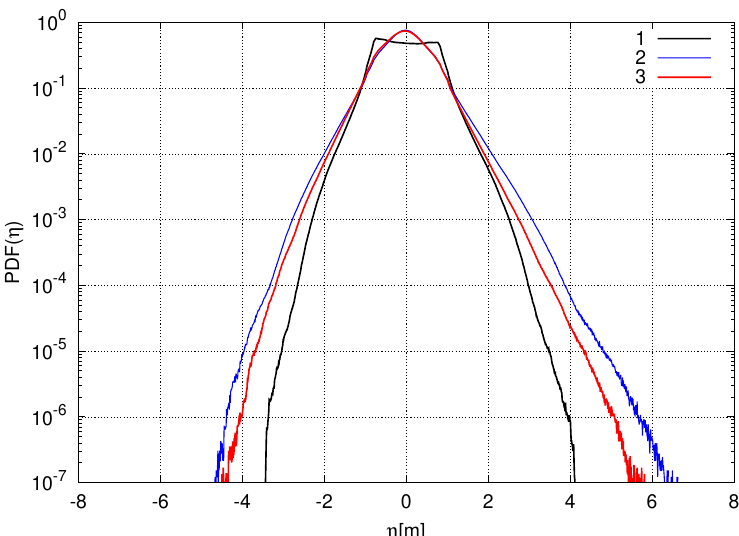
Figure 15. Probability density functions of surface amplitude PDF ( η ) in logarithmic scale for three different nonlinear models at µ = 0.04 and ˜ k p = 1. Black solid curve 1 corresponds to the NLSe model, blue solid curve 2—to the compact Dyachenko-Zakharov envelope equation and red solid curve 3—to the fully nonlinear